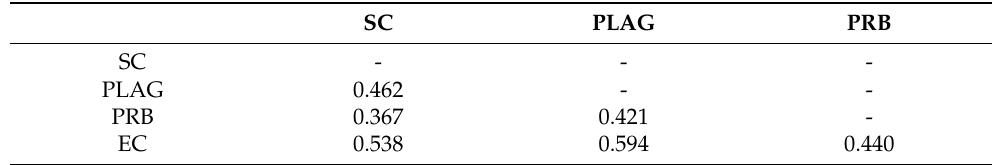
Table 9. Discriminant validity with